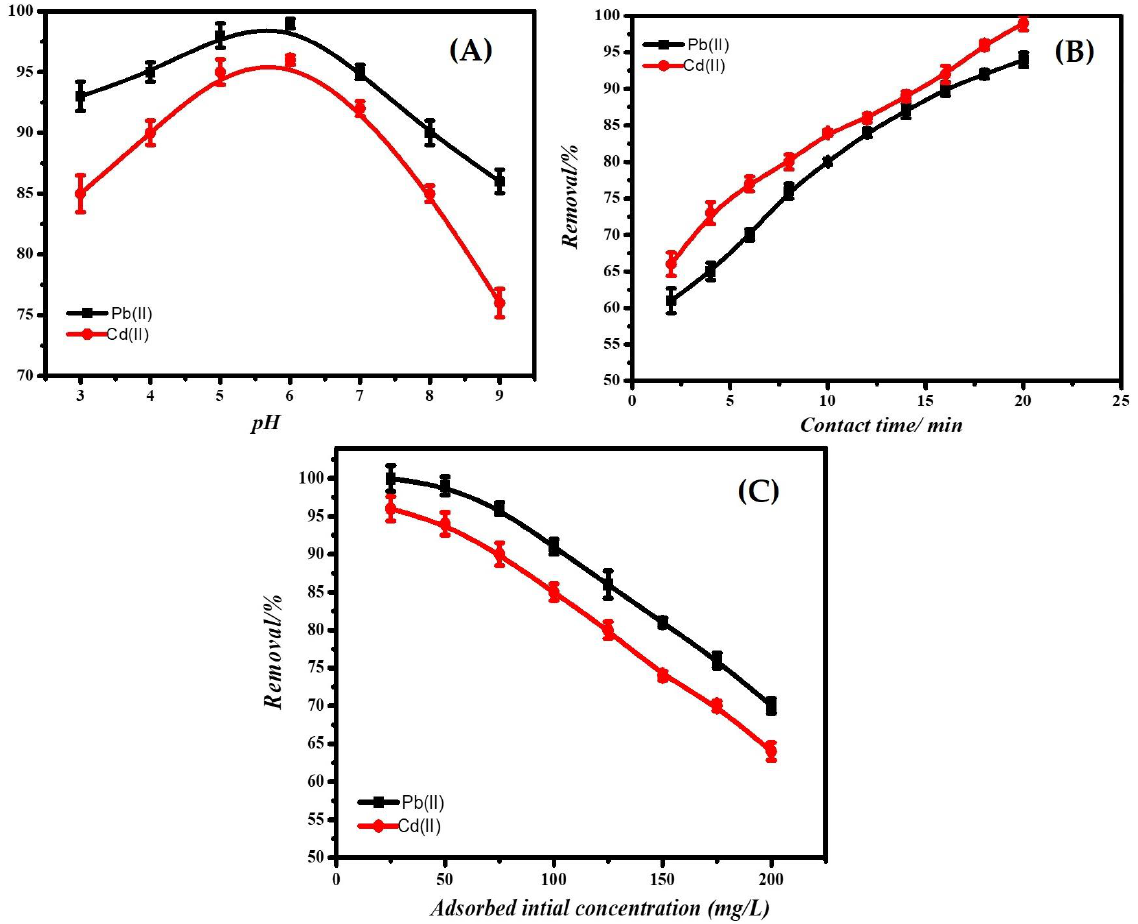
Figure 9. Removal% of Pb 2+ and Cd 2+ using ( A ), different contact time (min); ( B ), different initial adsorbed concentration (mg/L), and ( C ), different BI@MWCNTs dosage at pH 5 with three trials of each factor.